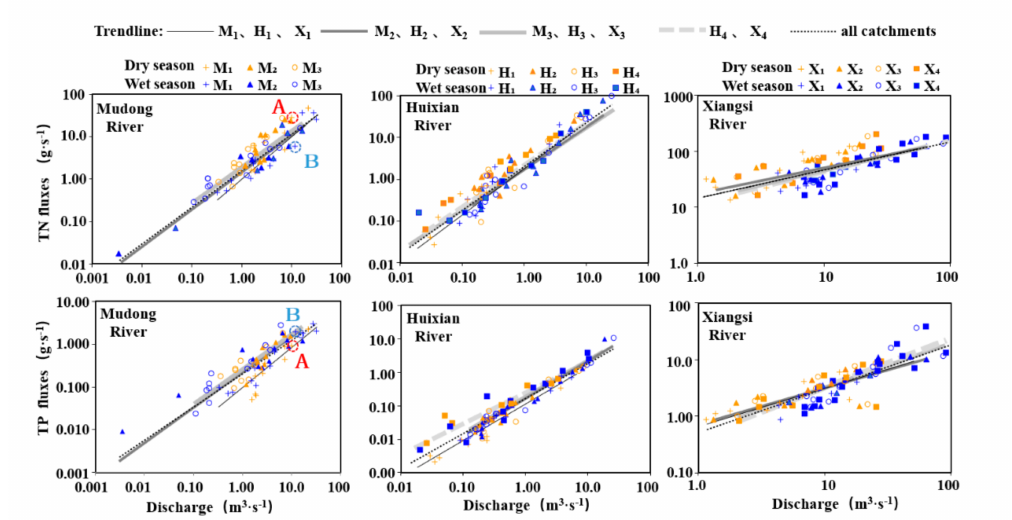
Figure 8. The relation between discharge and TN or TP fluxes of the eleven catchment scales for the three rivers in the dry and wet seasons.